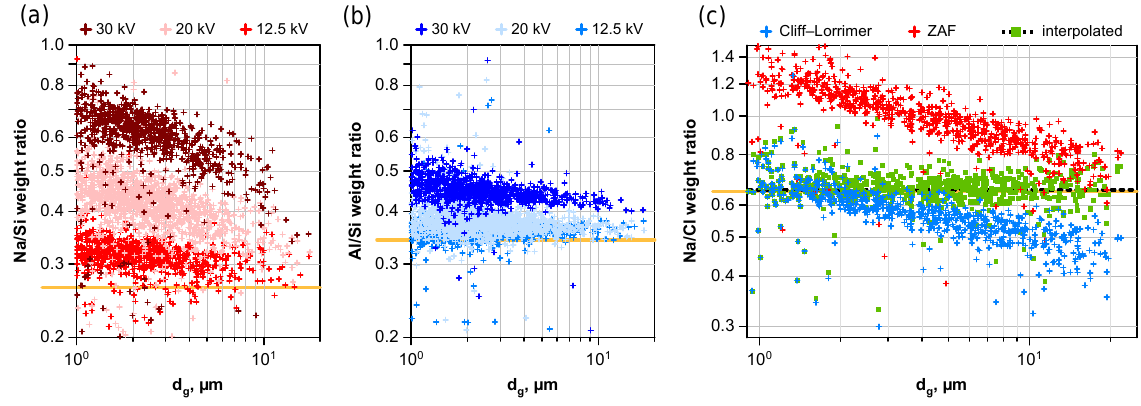
Figure 1. Comparison of element weight ratios for albite and sodium chloride powder as function of particle size. The nominal ratios for the compounds are shown as orange lines. (a, b) Albite ratios as function of acceleration voltage with ZAF correction. (c) Sodium chloride ratio at 20kV acceleration voltage, corrected by the methods Cliff–Lorrimer, ZAF and interpolated. The linear regression of the interpolated correction is shown as black striped line.